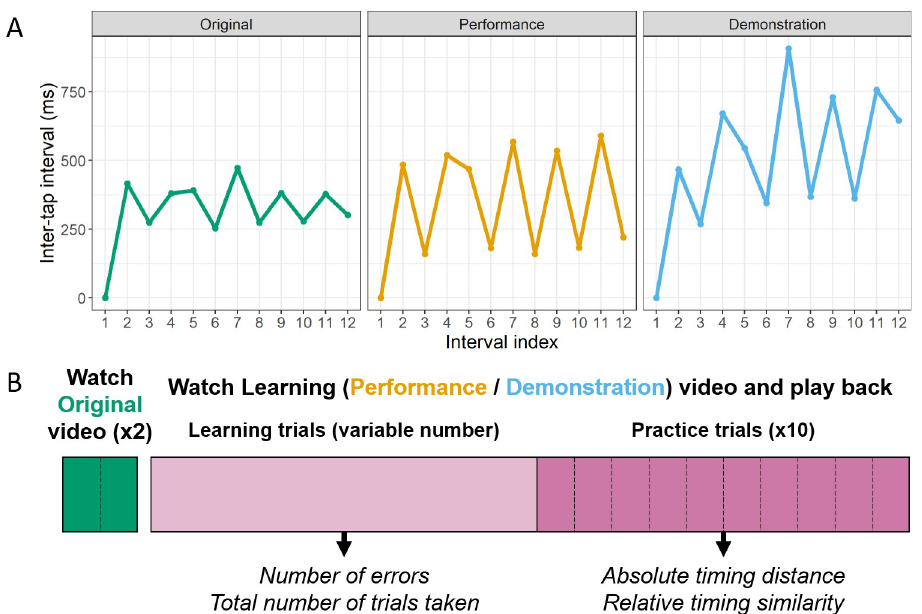
Fig 2. A. Inter-tap interval (ITI) sequences for each of the three model sequences. Interval index on the x-axis refers to the position of each ITI within the sequence (i.e. Interval index 2 refers to the interval between the first and second notes of the melody). B. Schematic timeline of the experiment. Participants start by watching the Original video through twice at the beginning of the experiment, without playing the piece back (green blocks). They then complete a turn-taking learning phase with the video (purple), where they watch the Learning video (the Performance or the Demonstration) and then play it back once each trial. For analysis purposes, this phase is split into two parts. Early learning trials (light purple) were used to gather data about errors and the number of trials taken to learn the piece. The last ten consecutive correct trials (practice trials; dark purple) were used as the criterion to end the learning phase and were used to derive data on the absolute and relative